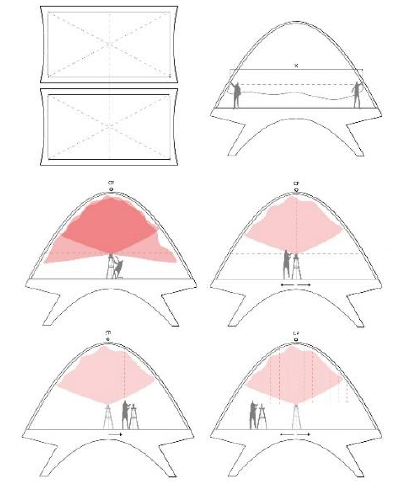
Figure 5. Cordero's diagram, showcasing her documentation process